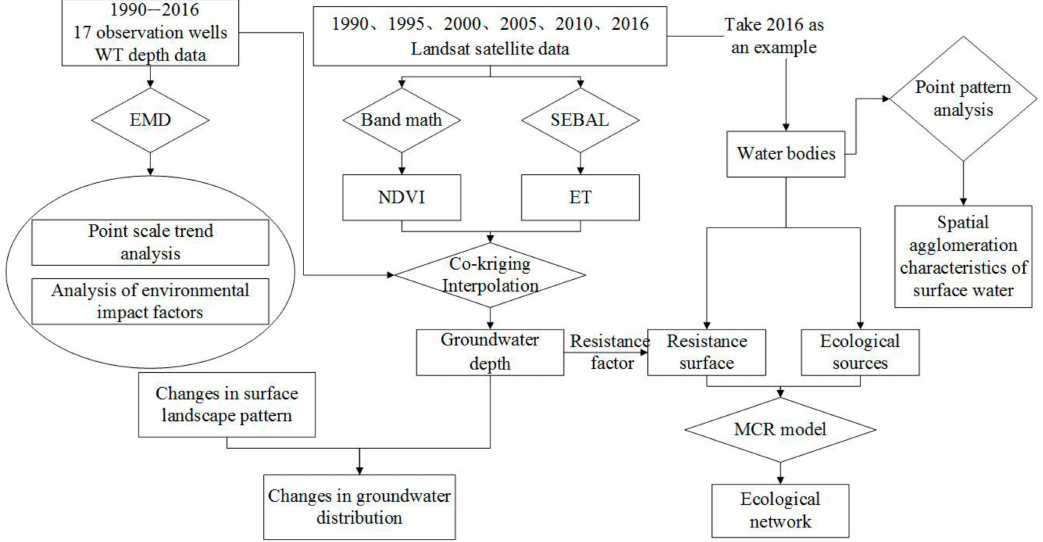
Figure 5. The overall flow chart of this